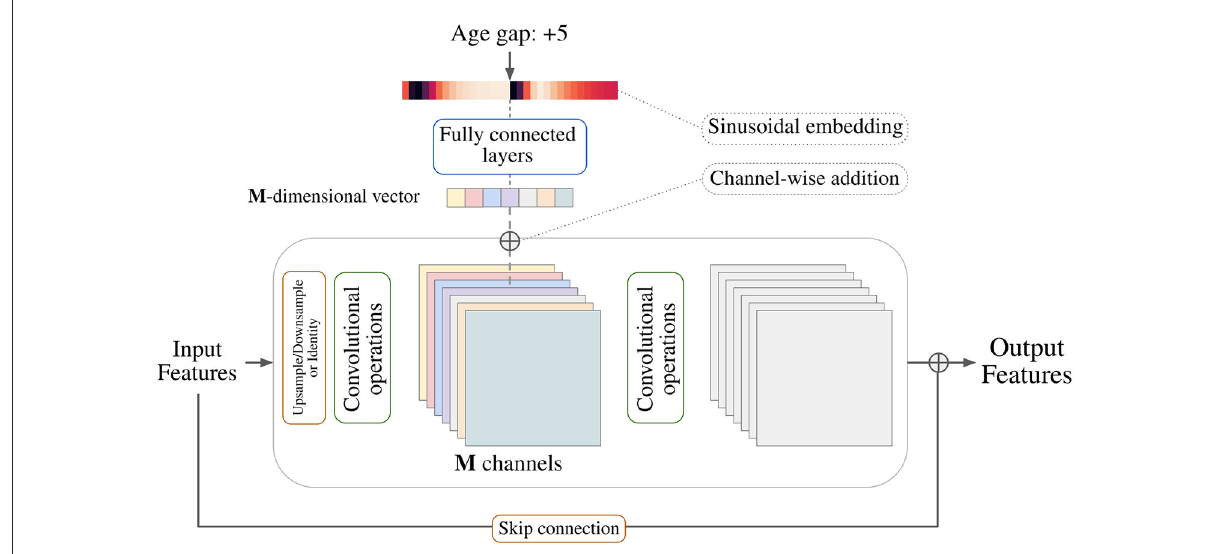
FIGURE2 Depiction of a general residual block and the conditional biasing mechanism used to pass covariates to the model. A sinusoidal embedding is applied to transform the scalar covariate into a vector that is later converted to a vector with the same dimensionality as the number of intermediate feature channels. Each value in the vector is then added to its corresponding channel in